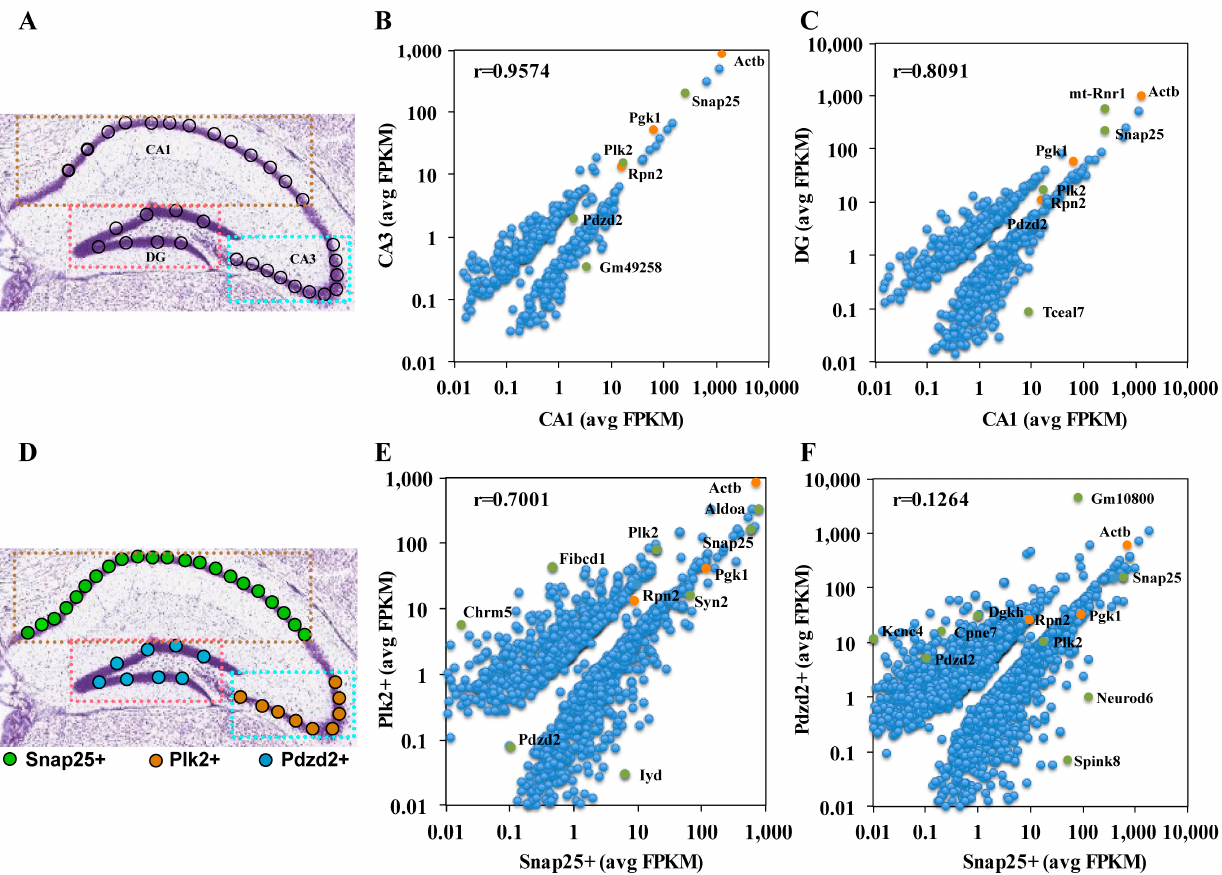
Figure 3. Gene expression profile analysis of tissue domain. ( A ) The single-cell locations of the three subregions in the control group are shown. ( B ) Scatterplot of gene expression correlation between CA1 and CA3 subregions. ( C ) Scatterplot of gene expression correlation between CA1 and DG subregion. ( D ) The spatial expression of marker gene maps of different tissue domains in the hippocampus of Parkinson’s disease. ( E ) Analysis and comparison of differentially expressed genes between Snap25+ expression sites and Plk2+ expression sites. ( F ) Analysis and comparison of differentially expressed genes between Snap25+ expression sites and Pdzd2+ expression